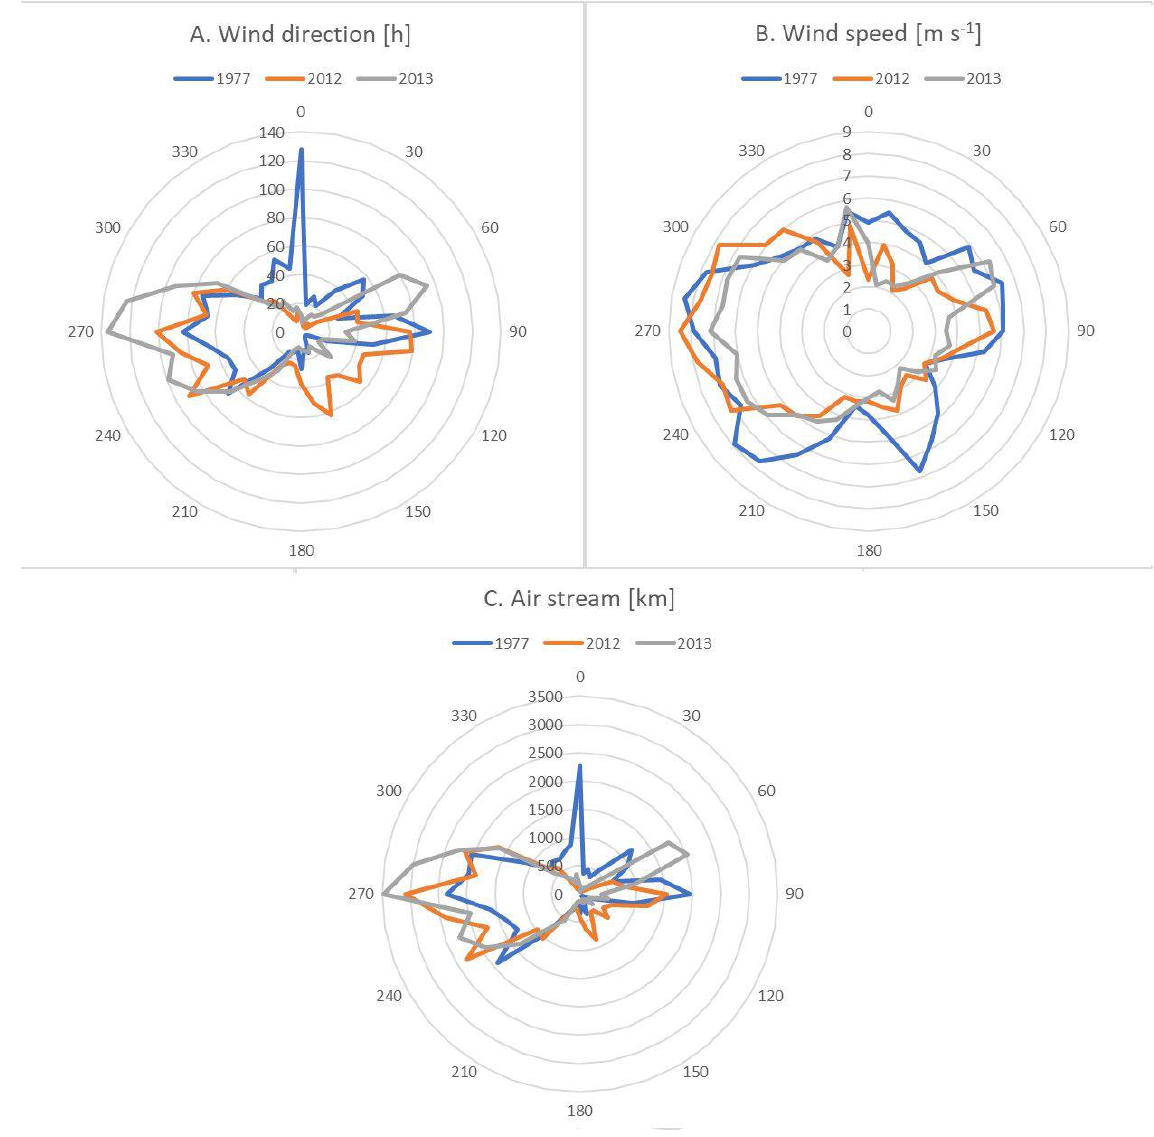
Figure S1: Frequency of w ind directions (A), average wind speed from different directions (B) and overall air stream from different directions (C), recorded at 54.5272° N 11.0580° E (meteorological station Fehmarn) between 1 st of July and 31 st of August in the years 1977, 2012 and 2013. Wind direction was recorded in hourly intervals and in increments of 10°. Wind speed was recorded in the same hourly intervals. Air stream is the overall length of the air stream coming from a given direction that passed the area within the recording period and was calculated by multiplication of data shown in A and B. Data kindly provided by Deutscher